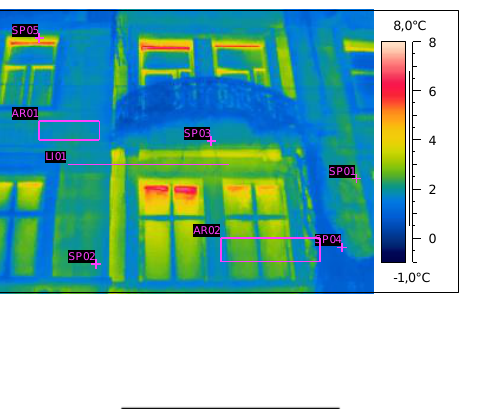
Figure 8. Courtyard-facing facade thermovision diagnostics with measurements.